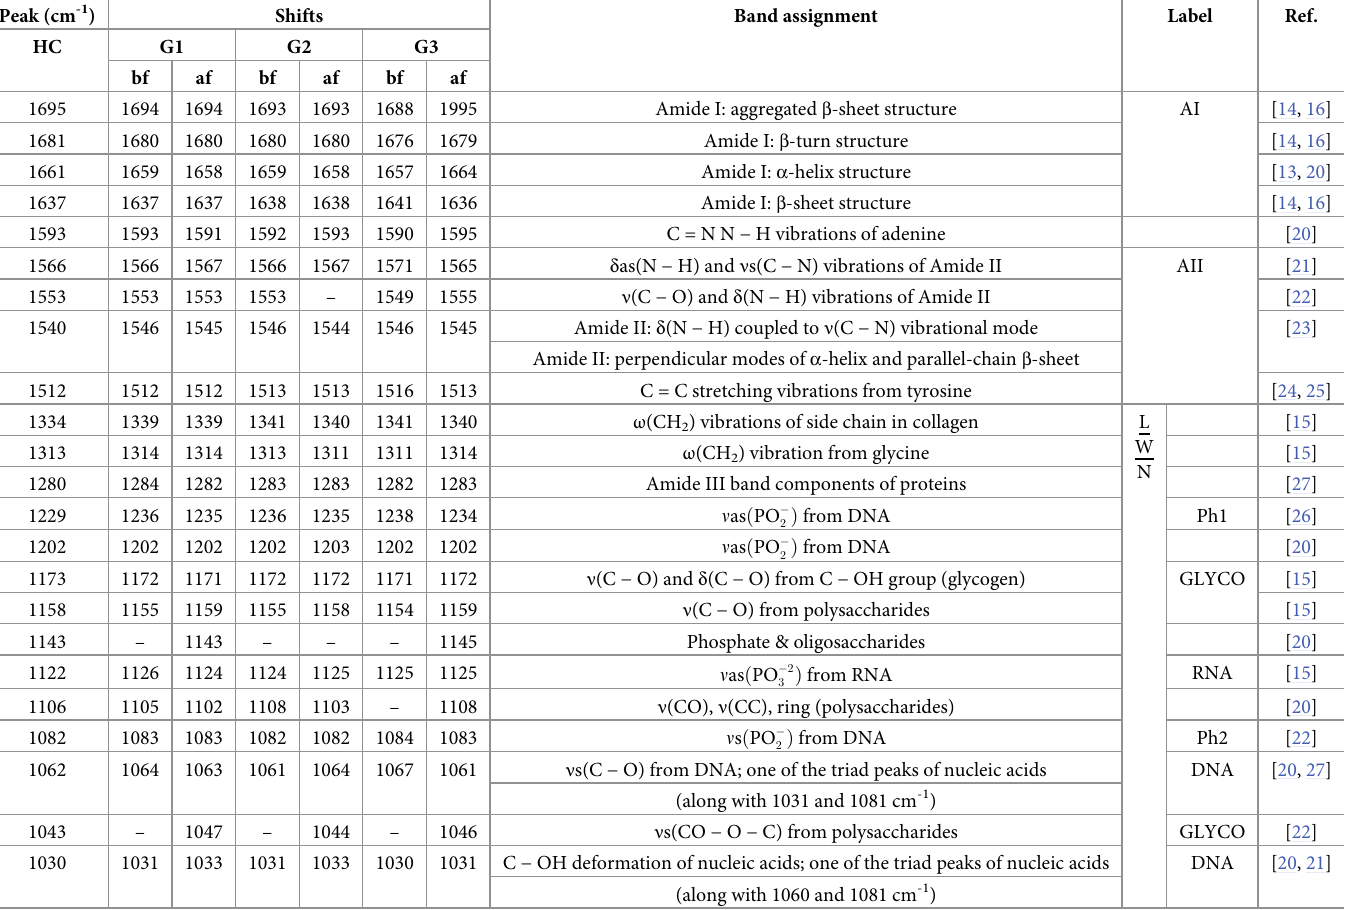
Table 1. Summary of mean values of wavenumbers (cm − 1 ) seen in FTIR spectra of TNBC and control breast tissue. For each peak the vibrational mode and the label are reported. Peak (cm -1 )